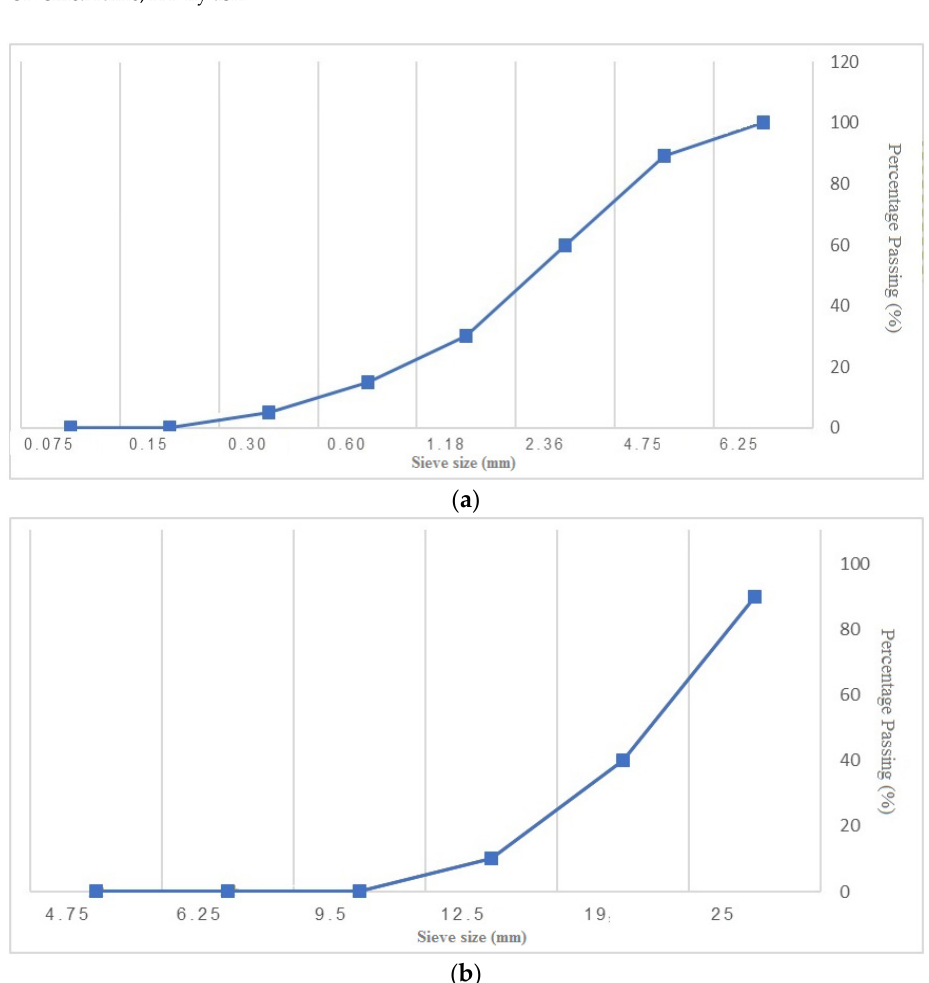
Figure 1. Sieving diagrams of ( a ) fine aggregates and ( b ) coarse